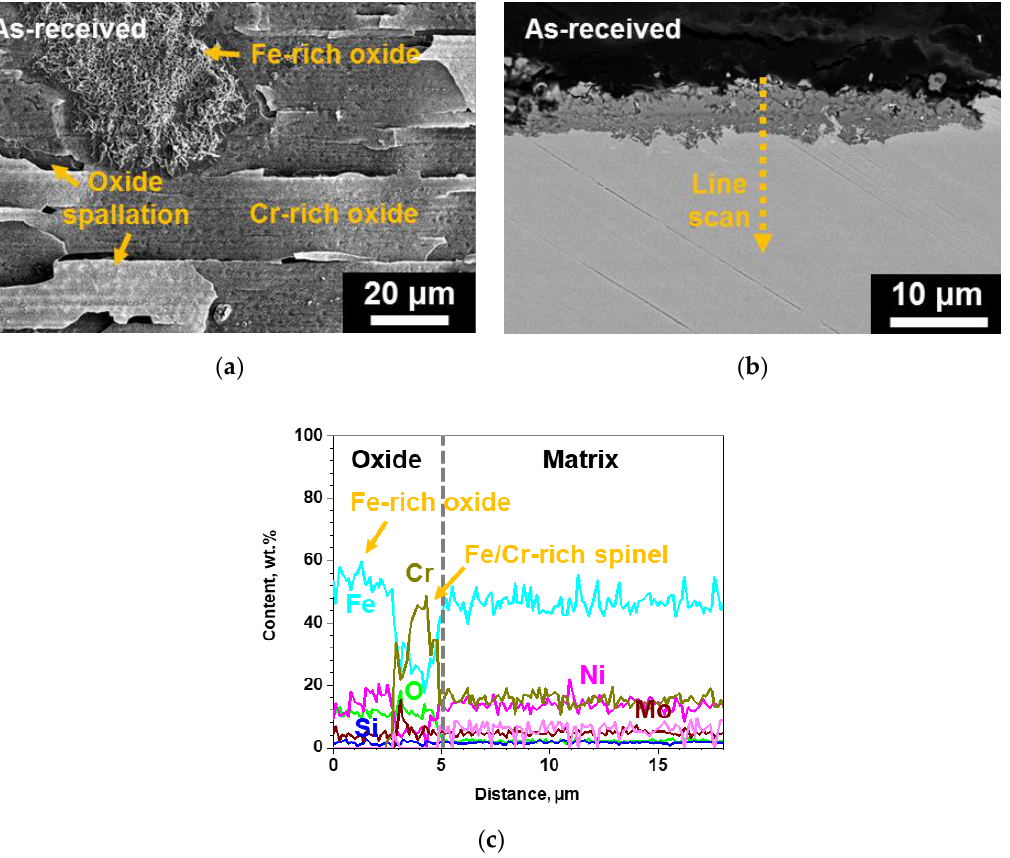
Figure 5. ( a ) Surface SEM, ( b ) cross-sectional BSE micrograph of the as-received SS 316LN after exposure to S-CO 2 at 650 °C (20 MPa) for 500 h, and ( c ) result of EDS line scan along the dotted line in (b).